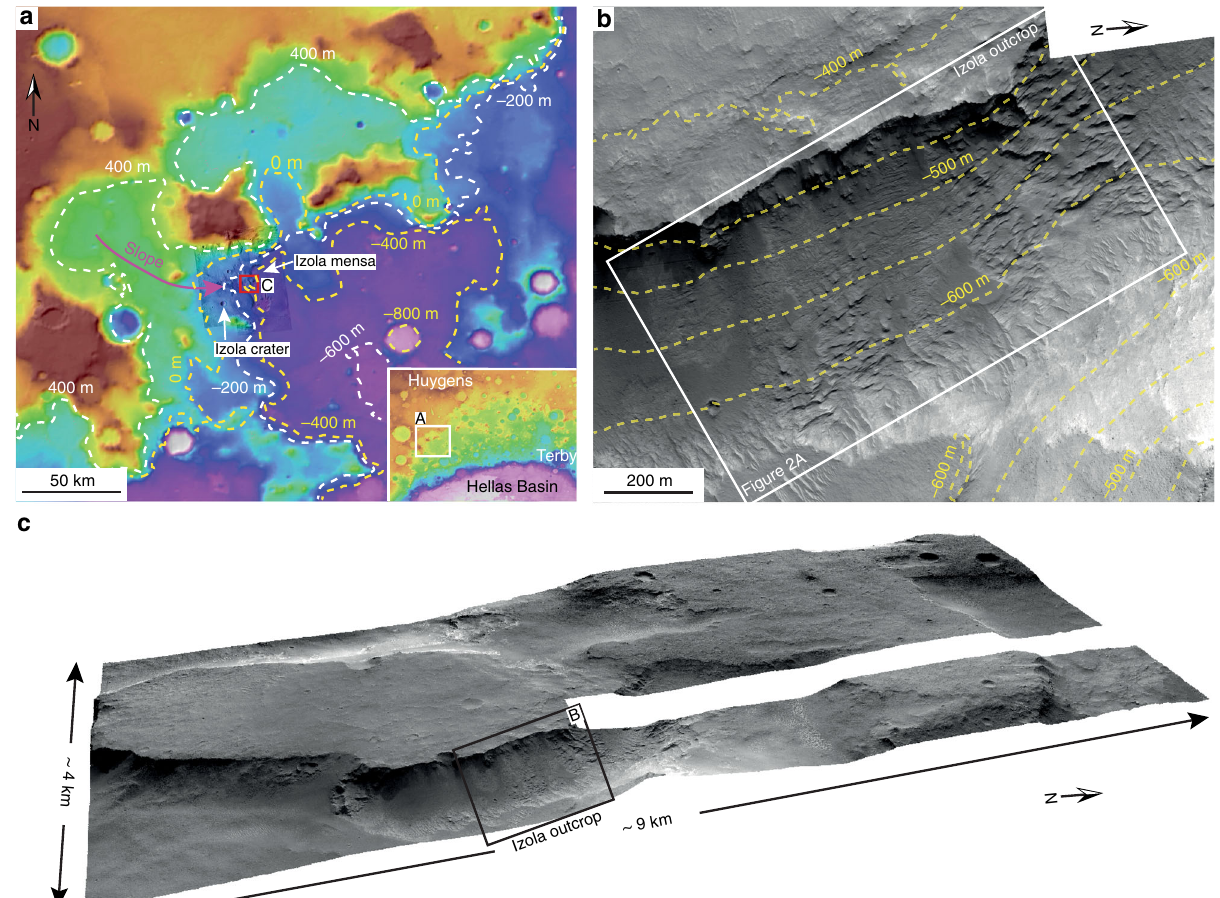
Fig. 1 General context of study location at Izola mensa. a Mars Orbiter Laser Altimeter (MOLA) topographic map centred on the NW rim of the Hellas basin, showing a depression (blue/violet) in the centre-lower right corner, the cratered highlands (brown-orange) in the upper left corner and the location of the studied outcrop within the red box. The magenta arrow indicates the slope direction of the modern surface. The identi fi ed macroforms suggest that the outcrop is broadly cut in the depositional-strike direction, in alignment with regional slope ( a ). The topographic elevation spans from 1500 m (brown) to − 1350 m (white). Bottom right inset shows the regional context. Mars Orbiter Laser Altimeter (MOLA) topographic map centred on the northwestern shoulder of the Hellas basin. Study area indicated by white box. The topographic elevation spans from 4319 m (brown) to − 8194 m (white). b High- resolution imaging science experiment (HiRISE) contour lines from HiRISE digital terrain model (1 m/pixel) (HiRISE stereo pairs ESP_055357_1540; PSP_003799_1540) over HiRISE visible image (25 cm/pixel). The Izola outcrop is located at 25.88°S and 54.29°E and faces almost N-S. c 3D view without vertical exaggeration of the Izola outcrop shown in b . HiRISE ESP_055357_1540 (25 cm/pixel) draped on HiRISE digital terrain model (1 m/pixel). Table 1 Hierarchical division of bounding surfaces applied in this study.